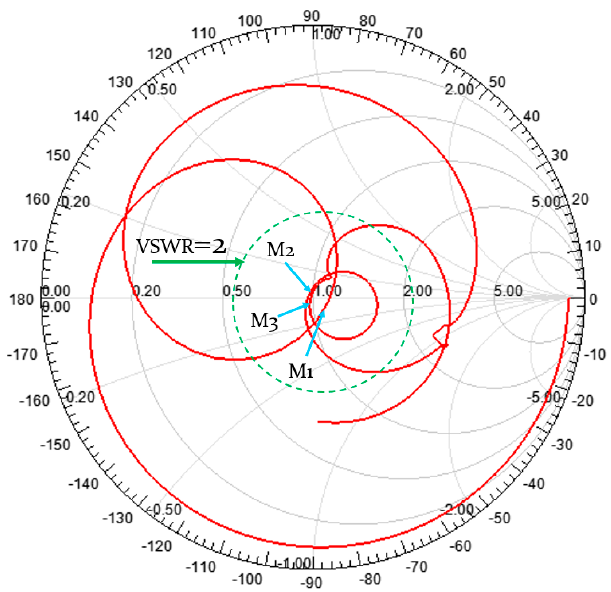
Figure 7. Smith chart of simulated antenna matched to 50 Ω . Table 3. Smith chart value of the proposed antenna.